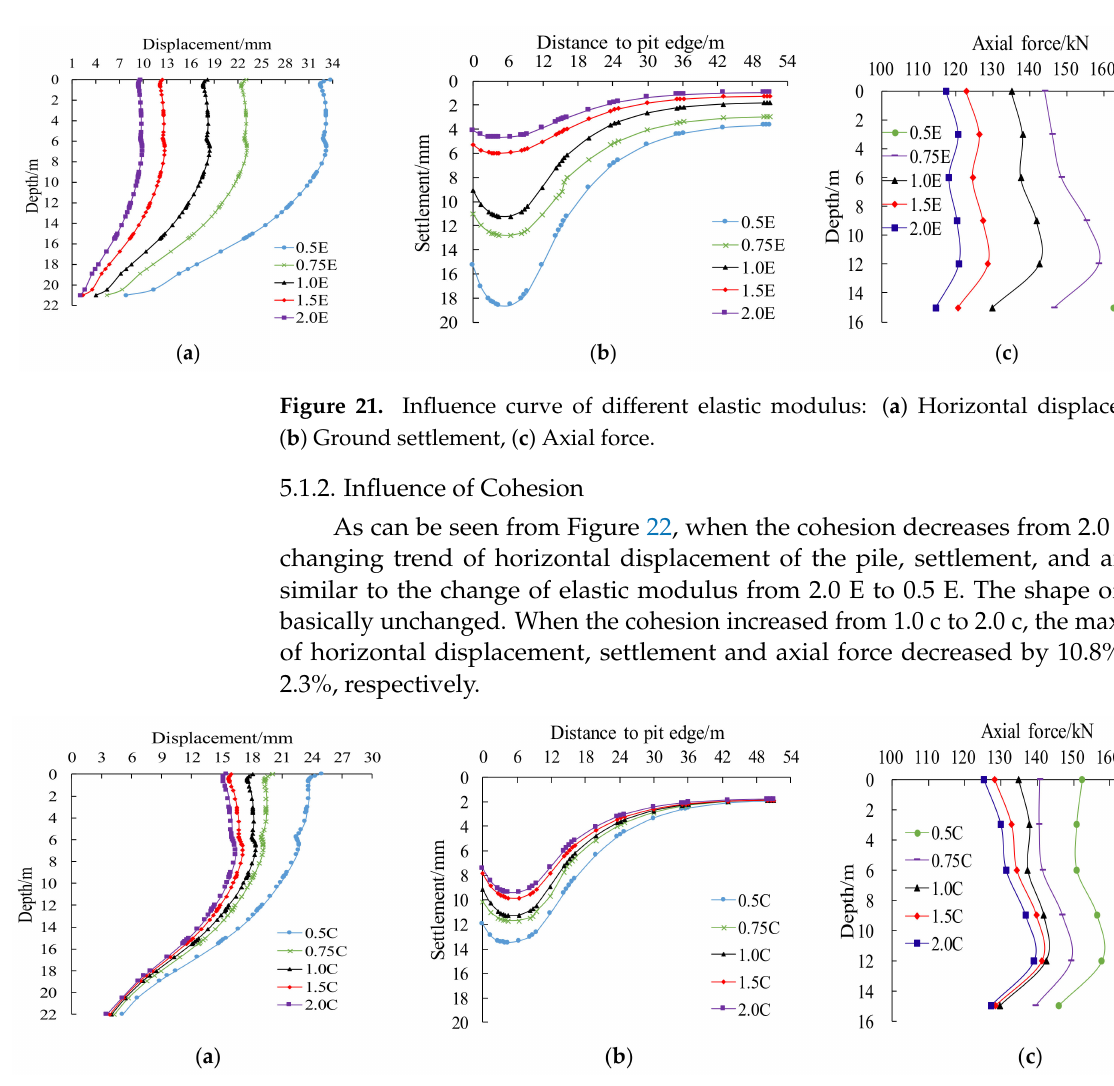
Figure 22. Influence curve of different cohesion: ( a ) Horizontal displacement of piles, ( b ) Ground settlement, ( c ) Axial